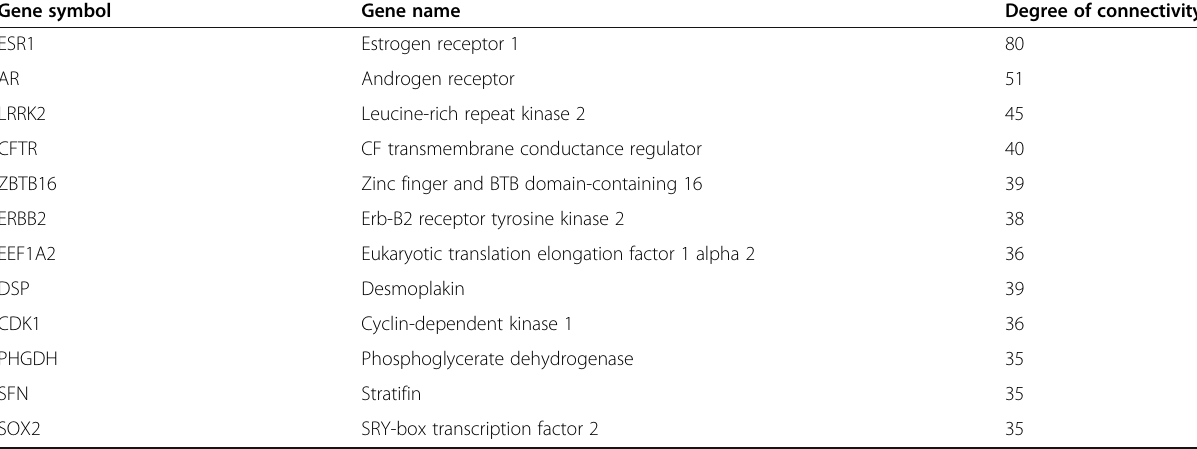
Table 5 List of hub genes and value of the degree of connectivity Gene